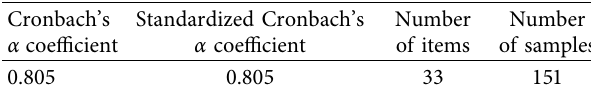
Table 3: Overall reliability analysis data.